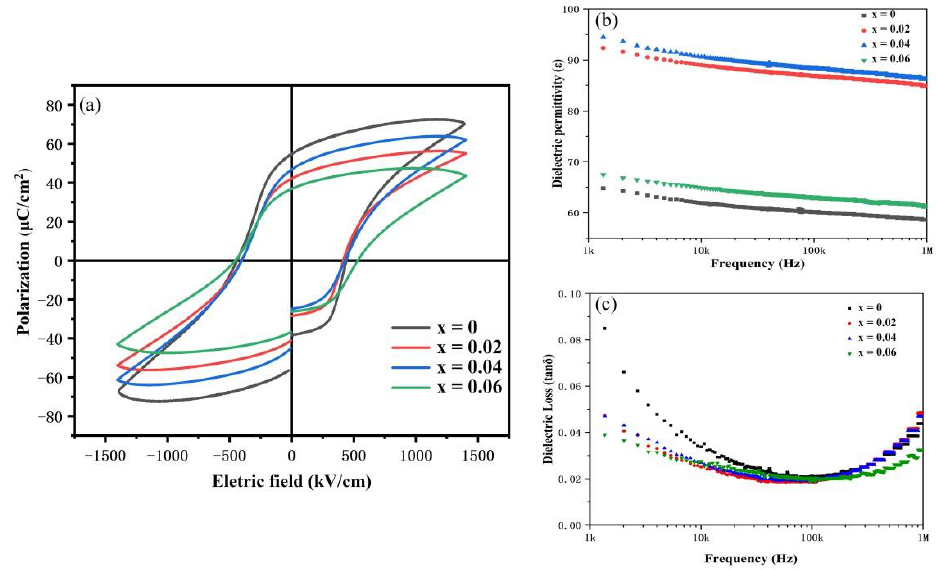
Figure 8. ( a ) P−E hysteresis loops, ( b ) dielectric permittivity, and ( c ) dielectric loss of the BSFM films with different Sm content. with different Sm